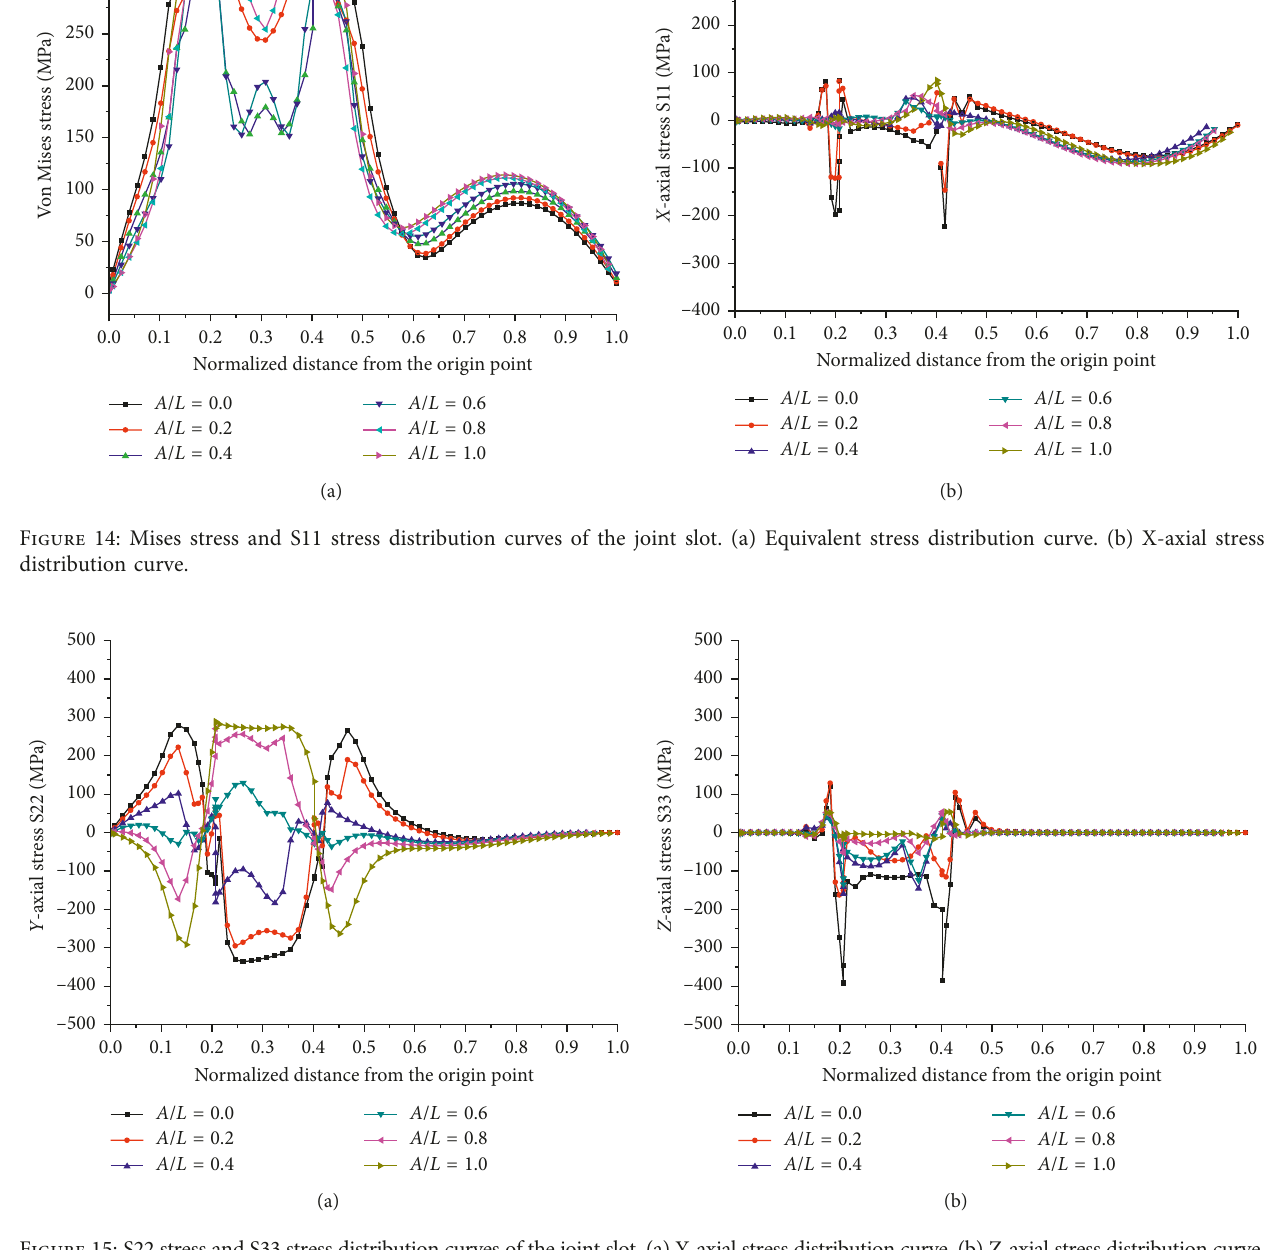
Figure 15: S22 stress and S33 stress distribution curves of the joint slot. (a) Y-axial stress distribution curve. (b) Z-axial stress distribution